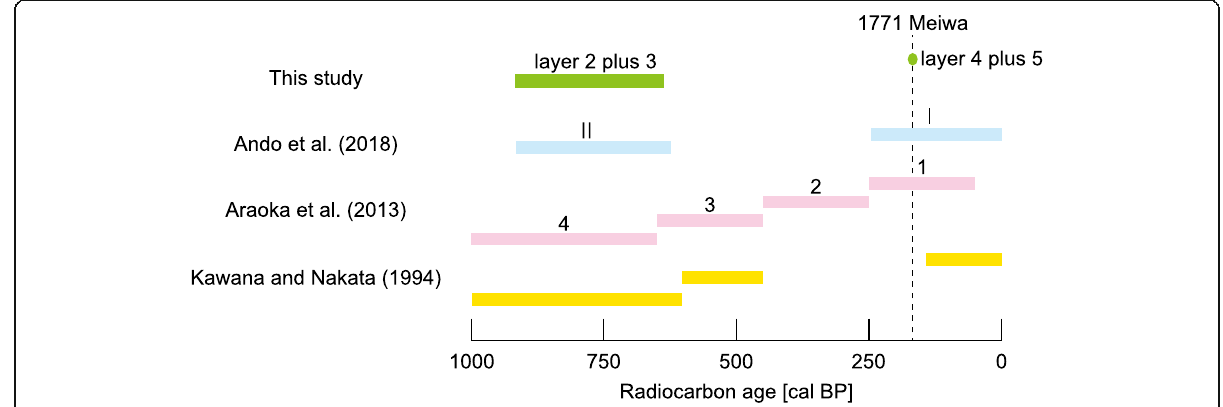
Fig. 9 Interpretation of paleotsunami histories: green lines, this study; blue lines, Ando et al. (2018); pink lines, Araoka et al. (2013); yellow lines, Kawana and Nakata (1994). The age of L4 is not estimated by radiocarbon ages but by deposition